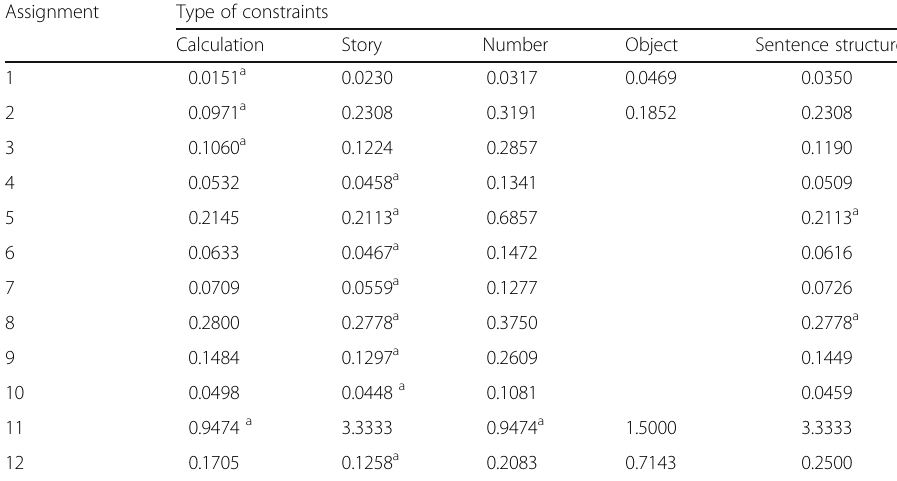
Table 4 Ratio of the number of states in the assignment setting to the occurrence frequency according to the type of constraints Assignment Type of